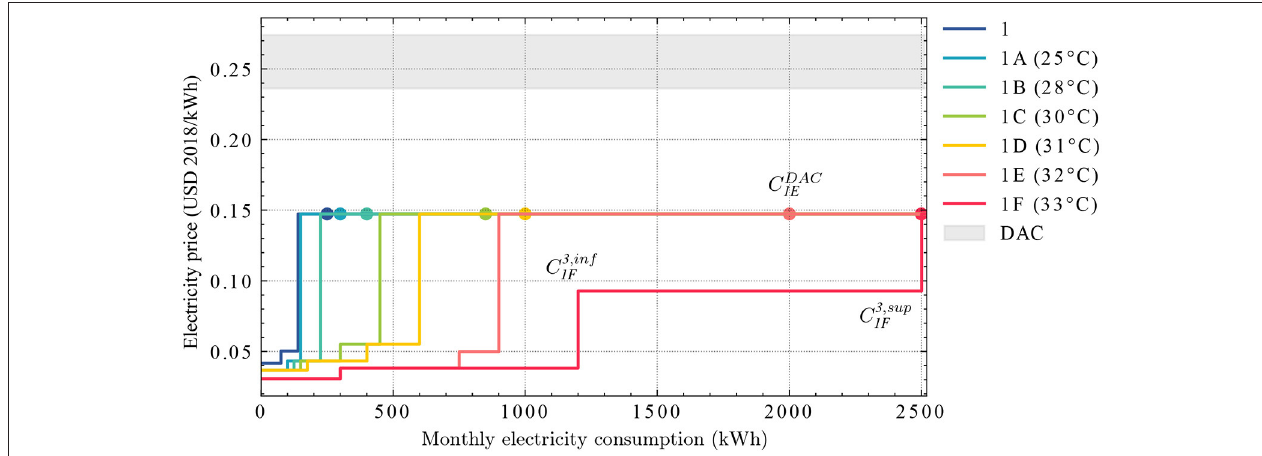
FIGURE 2 | Residential tariff scheme for Summer 2018 with increasing block prices for the seven regular tariff classes and the unsubsidized DAC tariff. The mathematical notations of the monthly consumption threshold to be considered a DAC user for tariff class 1E and the inferior and superior limits for the third consumption block of tariff class 1F, C DAC 1E , C 3 , inf 1F and C 3 , sup 1F , are displayed for illustrative purposes.